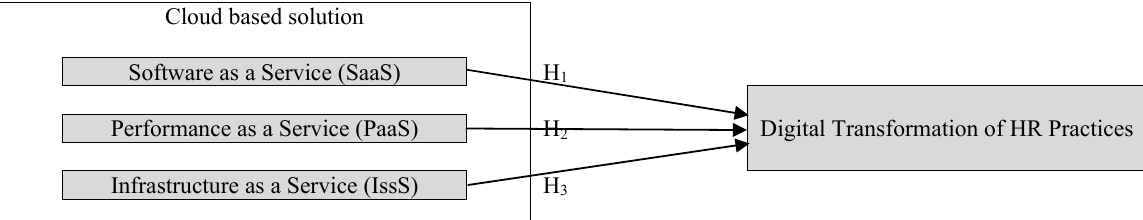
Fig. 1. The proposed method of the